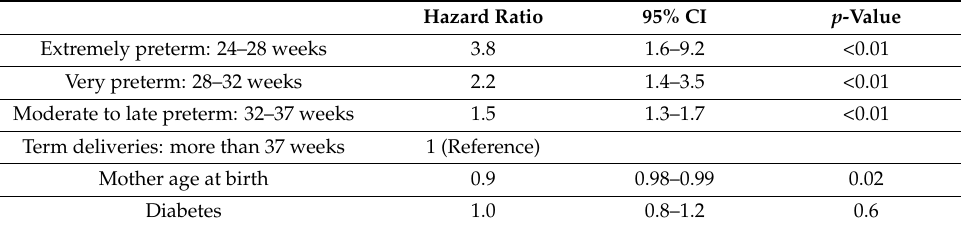
Table 4. Cox regression analysis of the association between week of birth and ophthalmic-related hospitalization of children (age <